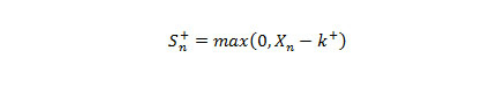
Figure 8. Historical negative binomial cumulative sum (CUSUM) equation. k = reference value, S n = CUSUM score, X n = the case count of the current week, + superscript refers to values always being